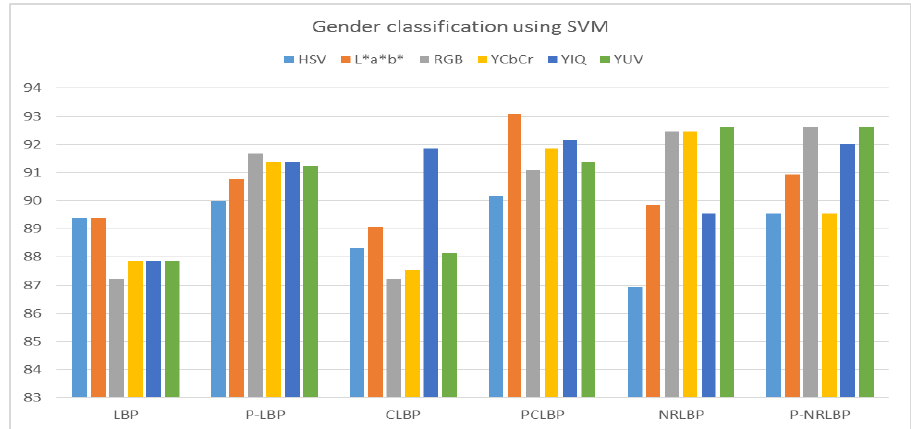
Figure 4. Gender classification using SVM (FERET database).